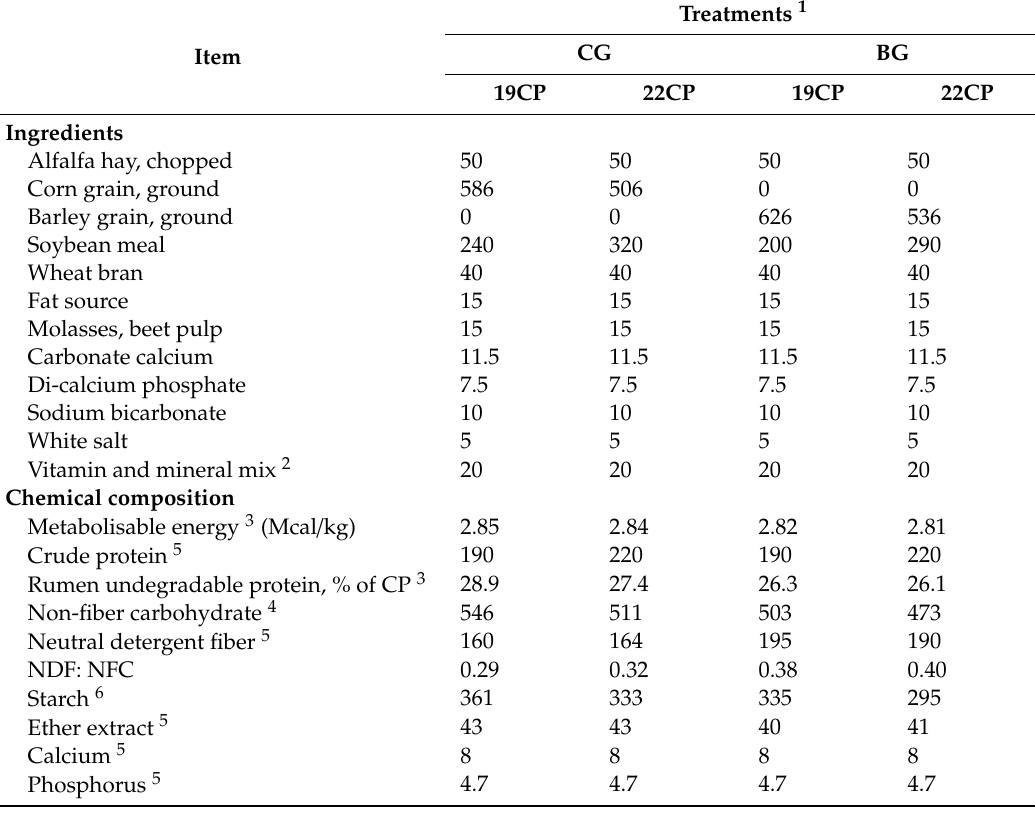
Table 1. Experimental starter diet ingredients, chemical composition (g / kg of DM, unless otherwise stated) and particle size distribution [% mean ± SD] of experimental